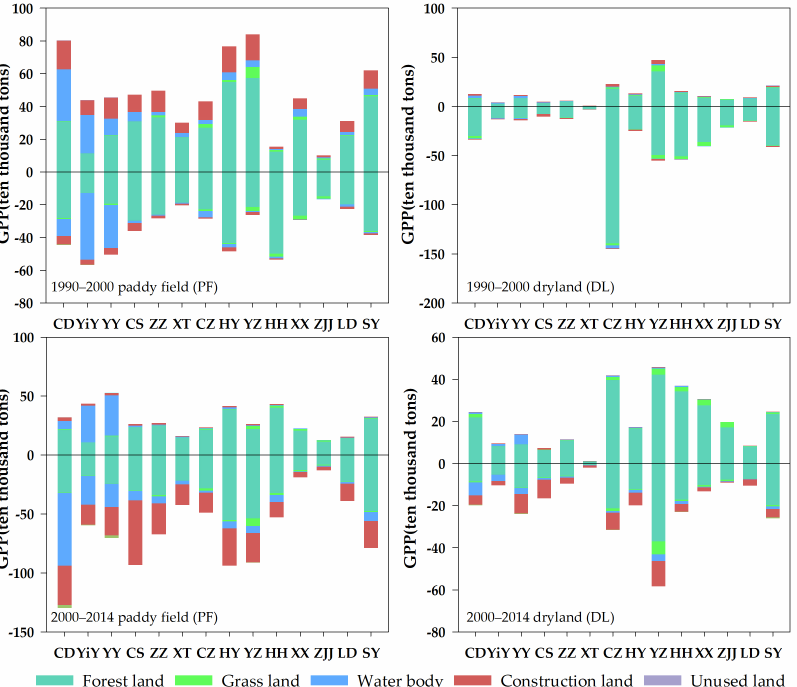
Figure 8. Impacts of cultivated land conversion and spatial location change on the grain production potential (GPP).